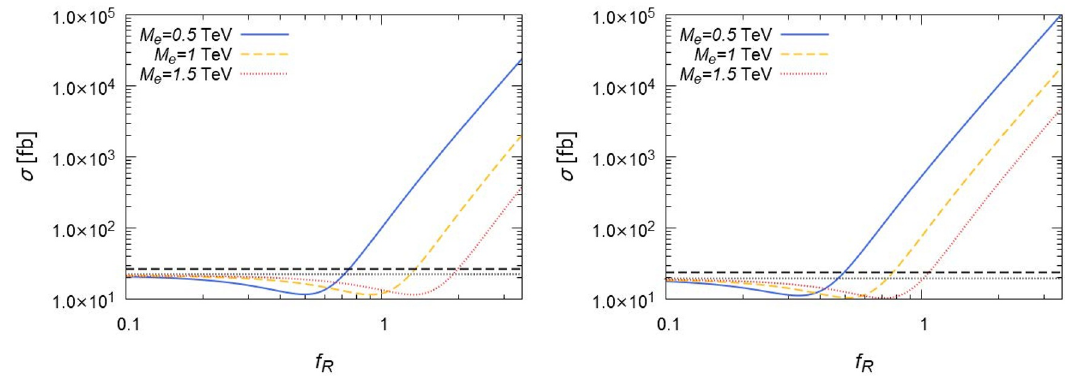
Figure 8 . Production cross section for the e + e − → η + coupling f e for m = 200 GeV and θ = π/ 4 . The left (right) plot shows the case with R η ± 1 500 (1000) GeV. The solid, dashed and dotted curves show the cases with M e = 0 . 5 , 1 and 1.5 TeV, respectively. The horizontal dashed and dotted lines show the cross section for θ = 0 ( η ± corresponding to the pure doublet state) and θ = π/ 2 ( η ±